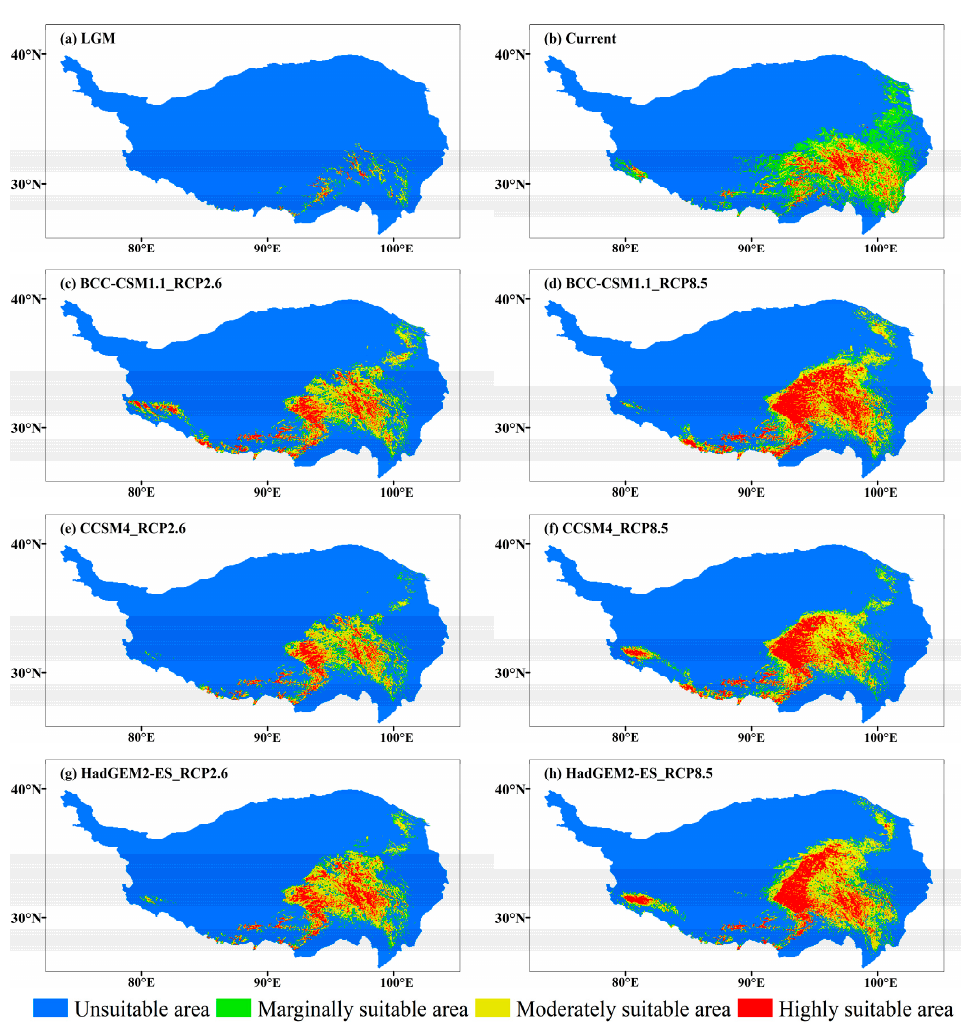
Figure 5. The suitable habitat of J. tibetica under different climate scenarios. ( a ) Suitable habitat during the LGM; ( b ) Current suitable habitat; ( c ) Suitable habitat for the BCC-CSM1.1 (RCP2.6) in 2070; ( d ) Suitable habitat for the BCC-CSM1.1 (RCP8.5) climate scenario in 2070; ( e ) Suitable habitat for the CCSM4 (RCP2.6) in 2070; ( f ) Suitable habitat for the CCSM4 (RCP8.5) in 2070; ( g ) Suitable habitat for the HadGEM2-ES (RCP2.6) in 2070; ( h ) Suitable habitat for the HadGEM2-ES (RCP8.5) in 2070.